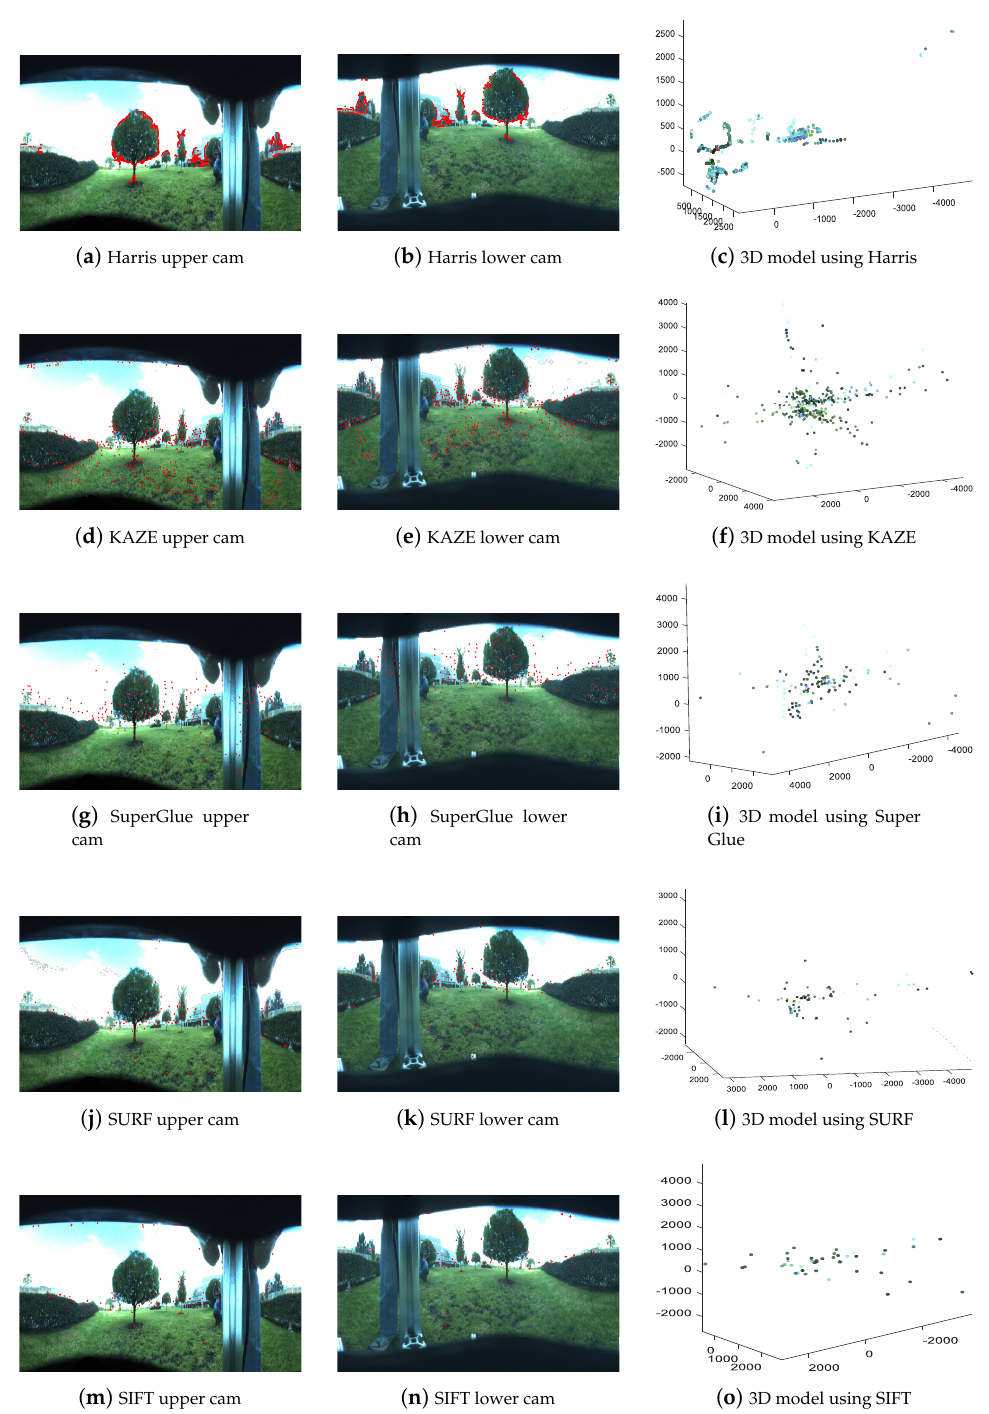
Figure 6. Feature matching points on the upper and lower cameras and 3D reconstruction for each comparing